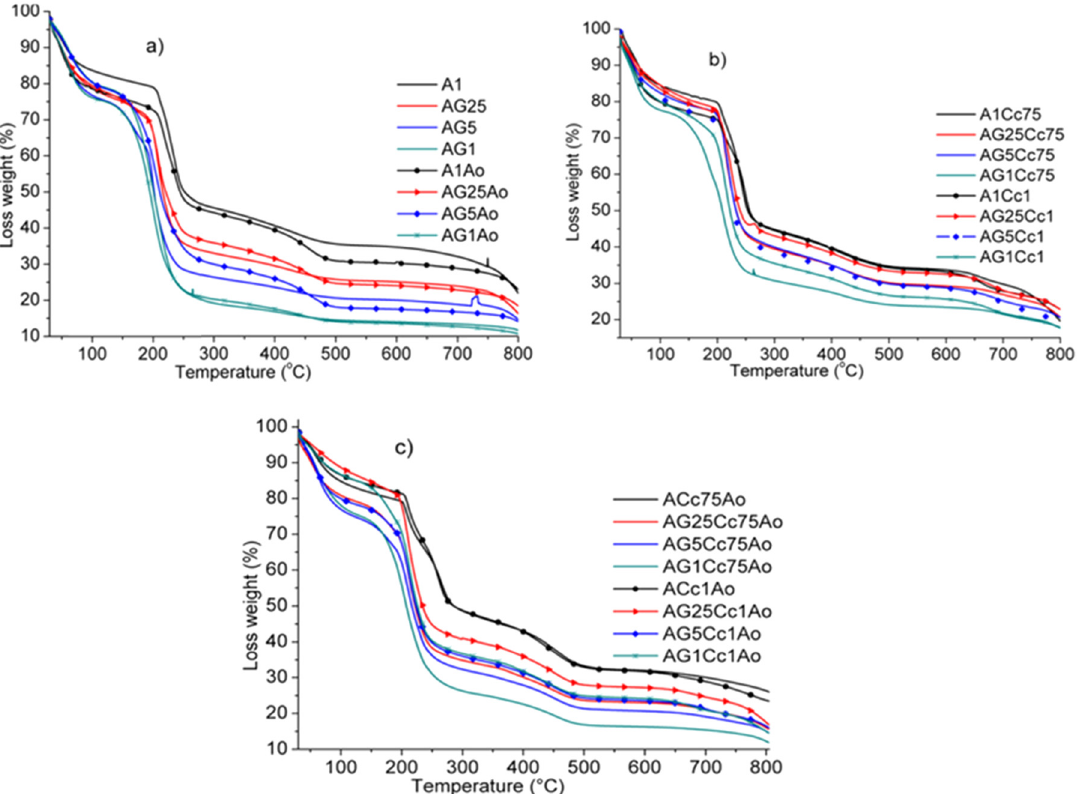
Figure 3: TGA plots of ( a ) none cross - linked and added with glycerol, without and with oleic acid; ( b ) cross - linked and added with glycerol; and ( c ) cross - linked and added with glycerol and oleic